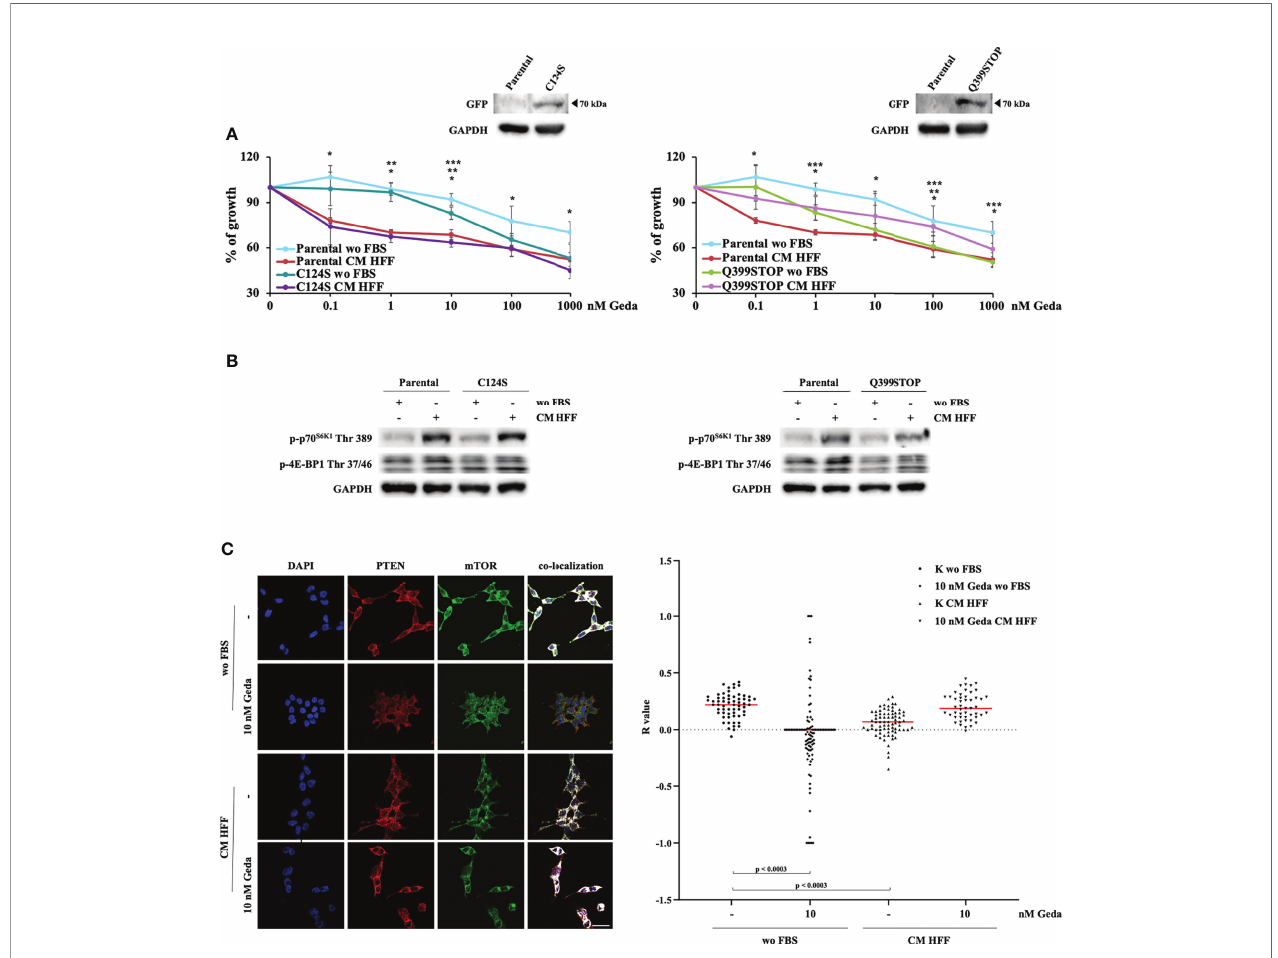
FIGURE 5 | PDZ PTEN domain mediates the effect of fi broblast-CM. (A) HCT116 Parental clones stably transfected with either a plasmid encoding PTEN C124S (C124S, left panel) or PTEN Q399STOP (Q399STOP, right panel) were treated with increasing doses of Geda (0.1-100 nM) in wo FBS or HFF-CM conditions. Cell viability was assessed by Crystal Violet assay after 72 h of treatment. Results are expressed as percentage of growth inhibition relative to untreated control and represent the average ± SEM of three independent experiments. Asterisks indicate statistically signi fi cant differences (p-value < 0.05 by 2-tailed Student ’ s t test) for the comparison between different conditions (*, **, *** for Parental wo FBS vs HFF-CM conditions, Clones (i.e. C124S or Q399STOP) wo FBS vs HFF-CM, Parental wo FBS vs Clones wo FBS conditions, respectively). (B) HCT1116 Parental, C124S clone (left panel) and Q399STOP clone (right panel) cell lines were grown under wo FBS and HFF-CM conditions. Cells were lysed and analyzed by Western Blotting using speci fi c antibodies (as indicated). GAPDH is shown as protein loading and blotting control. Results of a representative experiment out of three independent experiments performed are shown. (C) Colocalization analysis (representative images with white spots in left panel) con fi rmed a clear association in wo FBS condition and the lack of a speci fi c association in HFF-CM and 10 nM Geda wo FBS condition. Microphotographs were taken at ×63 magni fi cation. Scale bar: 50 m m. For the total sample (right panel), R values for control and 10 nM Geda in each condition of growth (wo FBS and HFF-CM) were analyzed by parametric unpaired t -test with Welch ’ s correction. PTEN/mTOR codistribution showed a signi fi cant pattern of superimposition in wo FBS condition as compared to both HFF-CM control condition and 10 nM Geda wo FBS condition. Results of a representative experiment out of three independent experiments performed are